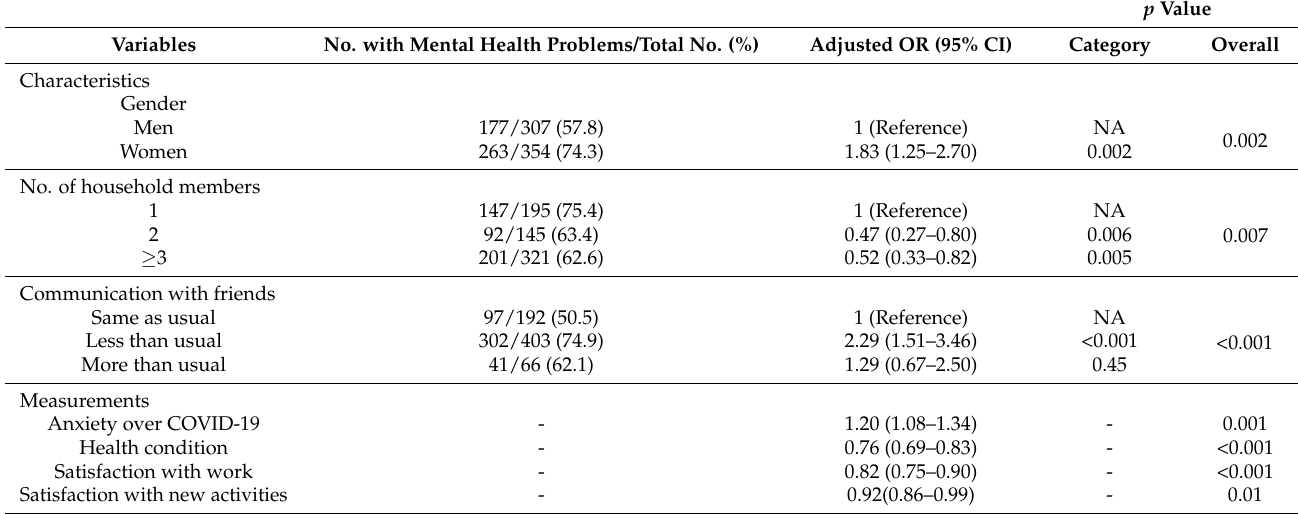
Table 4. Risk factors associated with severe mental health problems a